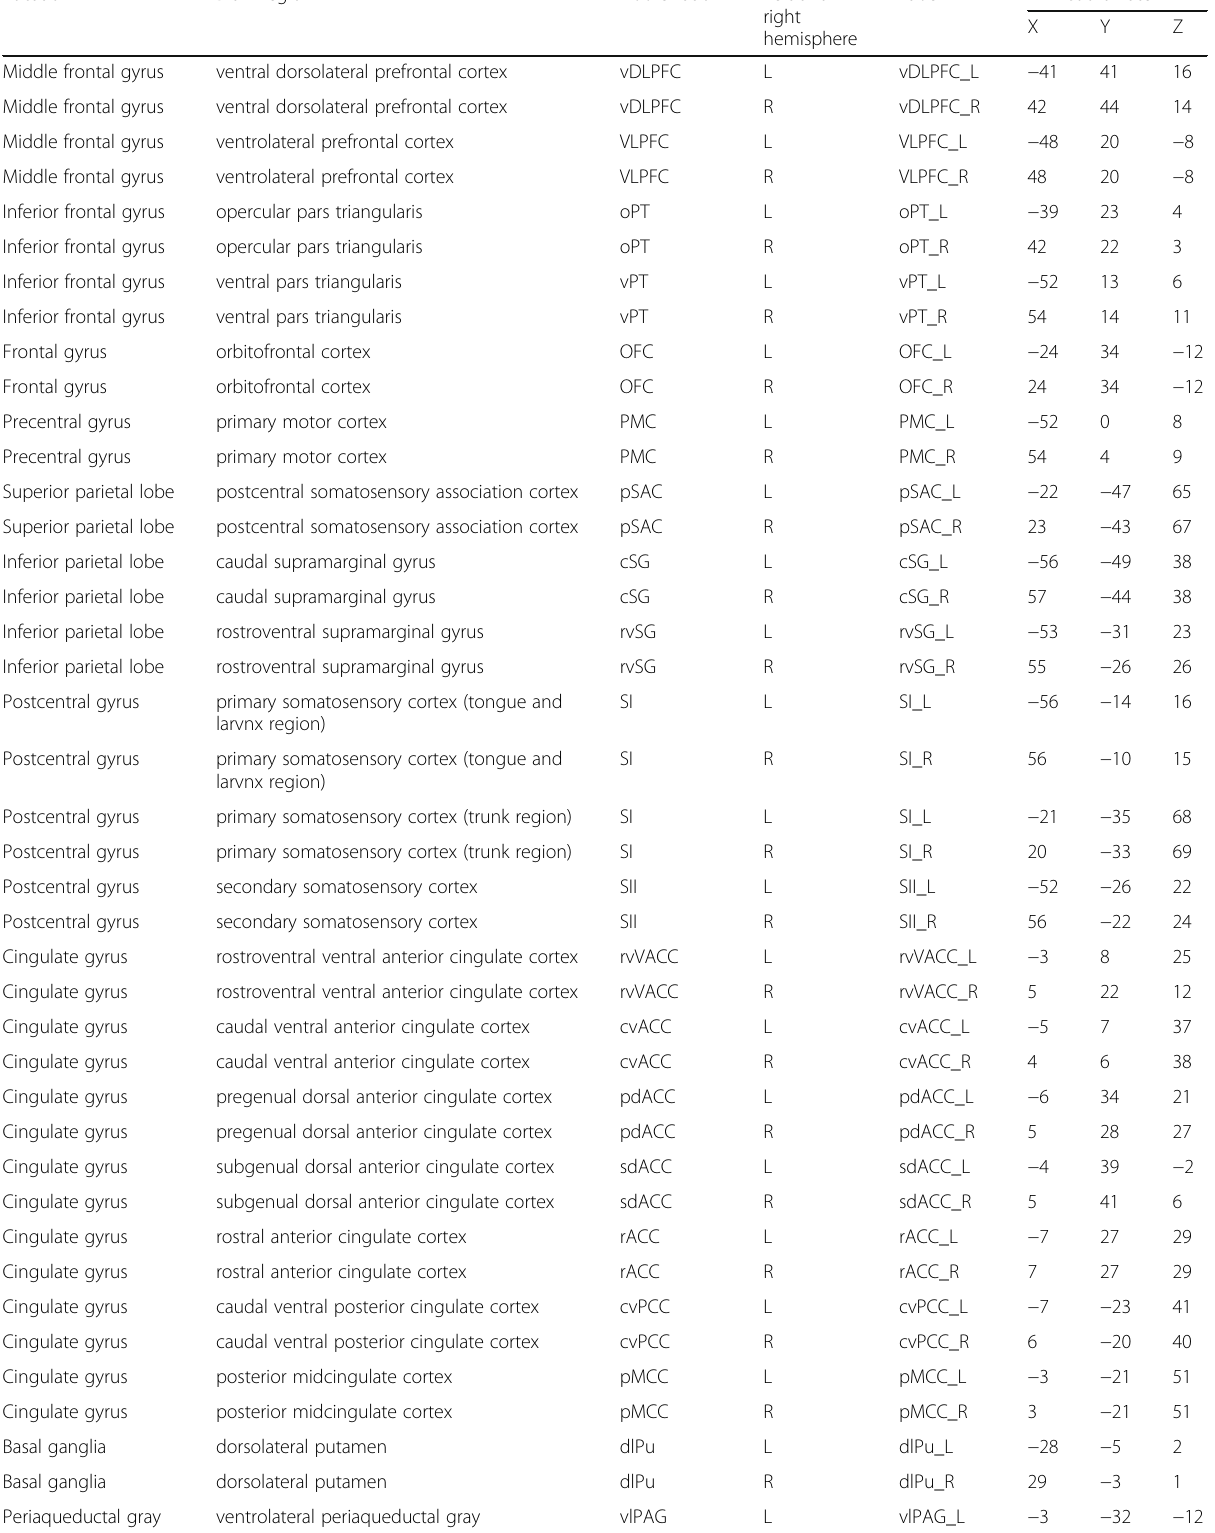
Table 2 MNI coordinates of the 64 selected pain-related brain regions